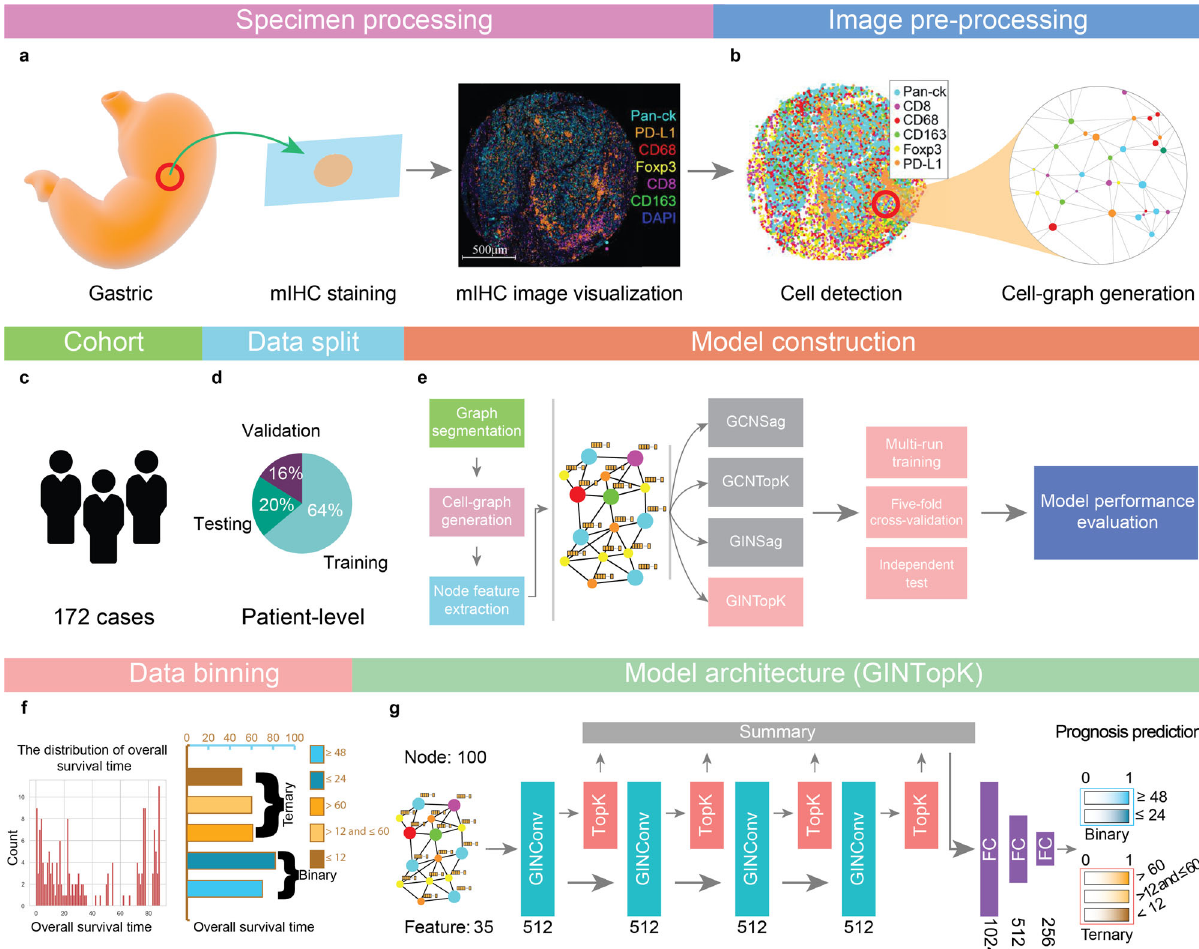
Fig. 1 An overall work fl ow of graph neural network-based prognosis prediction using Cell-Graphs. a Specimen processing: the tumor tissues were extracted from gastric cancer, and stained with seven different biomarkers including DAPI, Pan-CK, CD8, CD68, CD163, Foxp3, and PD-L1. b Image pre-processing: sub-sampling and cell-graph construction were conducted for image pre-processing. c An illustration for the cohort, 172 gastric cancer patients were collected. d Data split. The training, validation, and testing datasets were split with the percentages of 64%, 16%, and 20%, respectively. e Model construction: four different GNN model architectures, including GCNSag, GCNTopK, GINSag, and GINTopK, were constructed and compared. Multi-run model training, fi vefold cross-validation, and independent tests were conducted to evaluate the performance of the constructed GNN models. f Data binning: overall survival time ranged from 0 to 88 months, and two data- binning strategies were applied to generate binary- and ternary-class datasets. g Model architecture: The four models shared the same architecture but employed different types of convolutional unit and pooling layer, which consists of four consecutive convolutional layer and pooling layer blocks, followed by a summary layer and three fully connected layers, prior to the generation of the fi nal classi fi cation outcome. The architecture of the best-performing GINTopK model is illustrated herein, which outperformed the other three model architectures and also achieved the best performance on the test dataset. The corresponding number of hidden layers or feature dimensions is indicated at the bottom of each box. Here, FC stands for “ fully connected layer ”